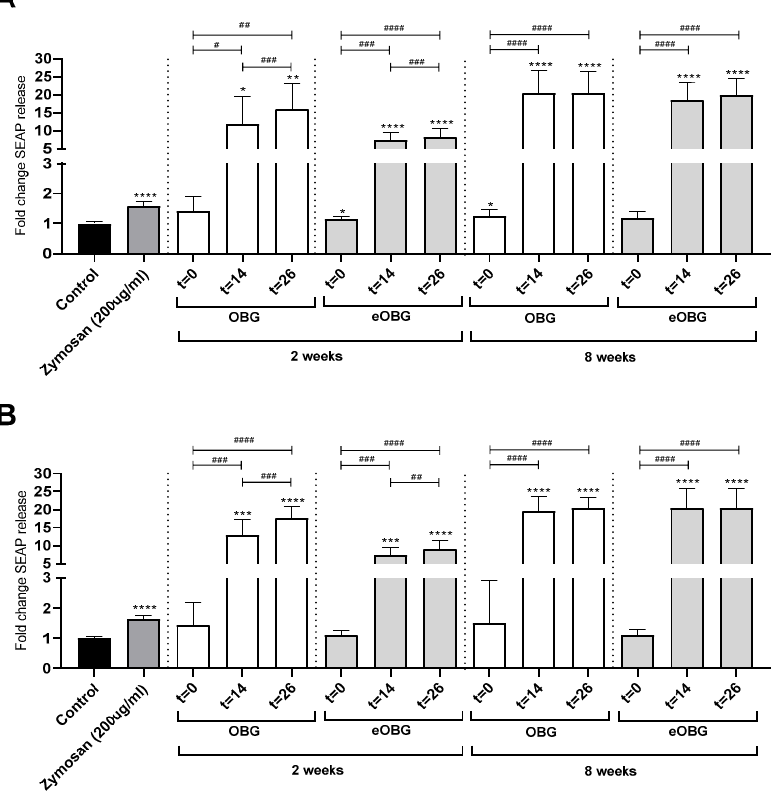
Figure 6. Relative NF- κ B release by ( A ) HEK-Dectin1a and ( B ) HEK-Dectin1b reporter cell stimulation with ( A ) samples of native oat β -glucan (OBG) and enzyme-treated oat β -glucan (eOBG) fermented with 2-week old fecal inoculum and ( B ) OBG and eOBG fermented with 8-week old fecal inoculum. For all groups, a medium control and Zymosan were included. Statistical di ff erences were tested using a OneWay ANOVA test followed by a Tukey’s multiple comparison test. Stars above bars represent statistical di ff erences compared to the medium control (* p < 0.05, ** p < 0.01, *** p < 0.001, **** p < 0.0001). Statistical di ff erences between t = 14 or t = 26 and the matched t = 0 are indicated above graphs (# p < 0.05, ## p < 0.01, ### p < 0.001, #### p < 0.0001). Experiments are repeated three times in triplicate.